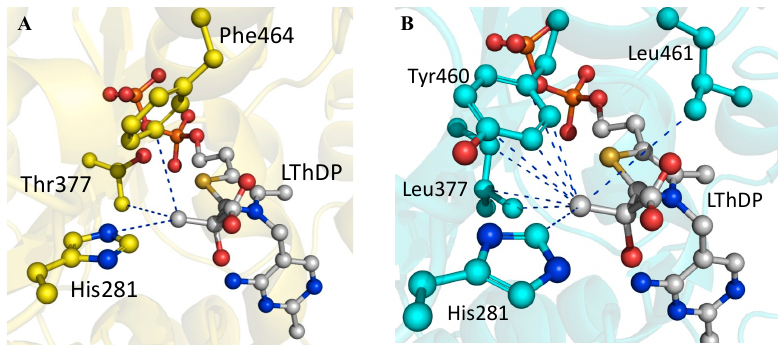
Figure 4. ( A ) wt BFDC (PDB: 1BFD) with LThDP (gray) placed into the active site by superposition of the LThDP on the corresponding atoms of ThDP. In total, three atoms are within 5 Å of the methyl group of LThDP; ( B ) BFDC T377L/A460Y PDB 4MZX) with LThDP (gray) superimposed on TZD. In total 10 atoms, from four residues, are within 5 Å of the methyl group of LThDP. In both structures blue lines indicate distances of <5 Å. Figure prepared using PyMOL with LThDP data from PDB ID 3OE1 [42].